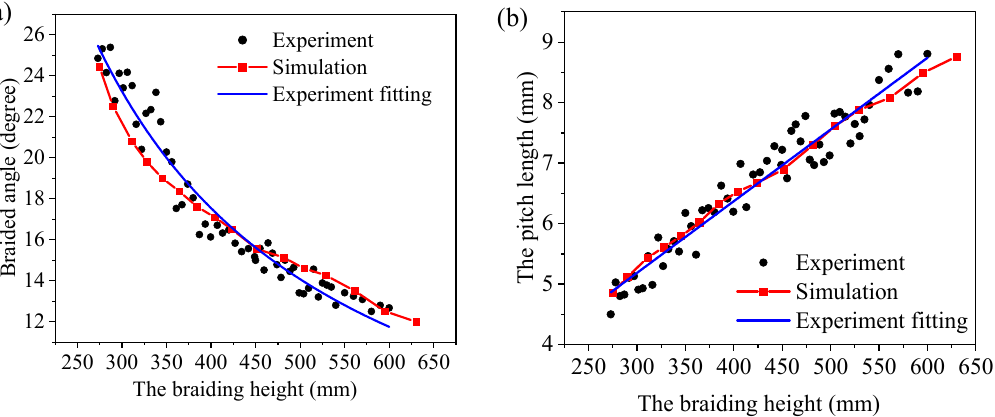
Figure 5. Comparison of simulation and experimental results: ( a ) the braiding angle and ( b ) the pitch length.